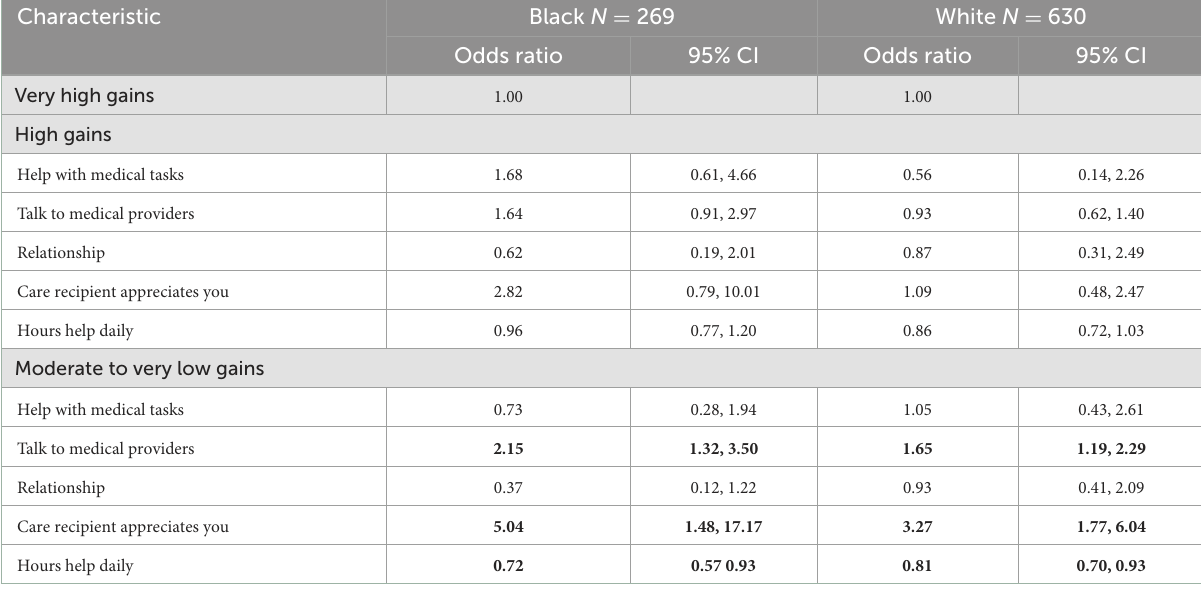
TABLE 5 Caregiver gains and aspects of caregiving.